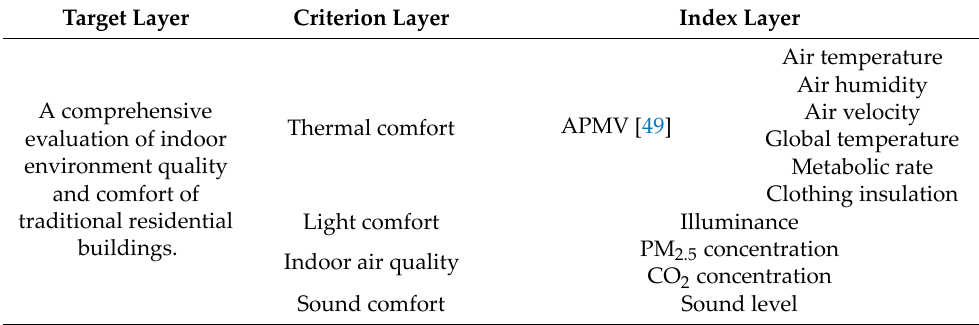
Table 1. Hierarchy structure of indoor environmental comfort evaluation of traditional residential